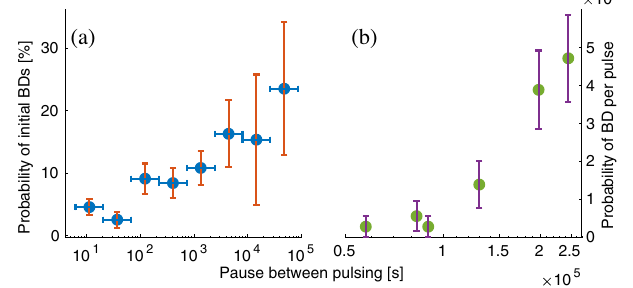
FIG. 8. (a) BD probability within the first second of running (2000 pulses) after a predetermined pause between pulsing runs, not preceded by a BD, with a pulsed dc system. The horizontal blue error bars indicate the range of the pause length values where the data were averaged. The vertical red error bars, again, indicate the uncertainty as the standard error of the mean. (b) The probability of BD, i.e., the BDR during the first 2 h of operation after a long pause in pulsing with a rf test stand. The violet vertical error bars indicate the uncertainty as the square root of the number of BD events.